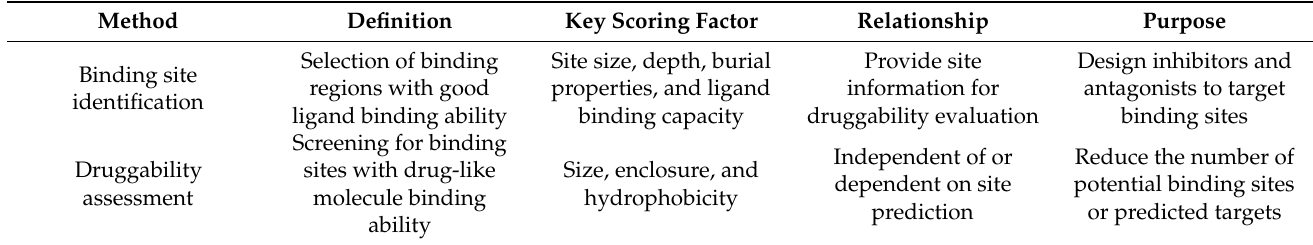
Table 3. Comparison of binding site identification and druggability